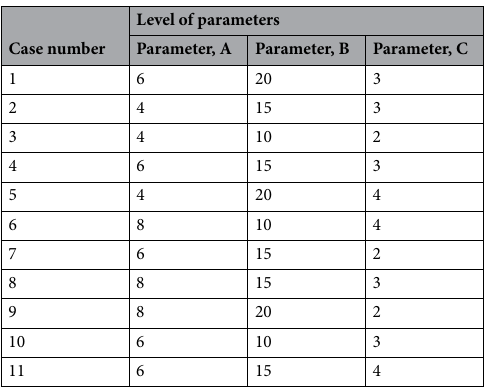
Table 4. CCD proposed cases for finned geometry with Power of LED = 1, 2 and 3 W Microchannel dimensions: Height = 100 mm; Width = 80 mm and Depth = 50 mm.